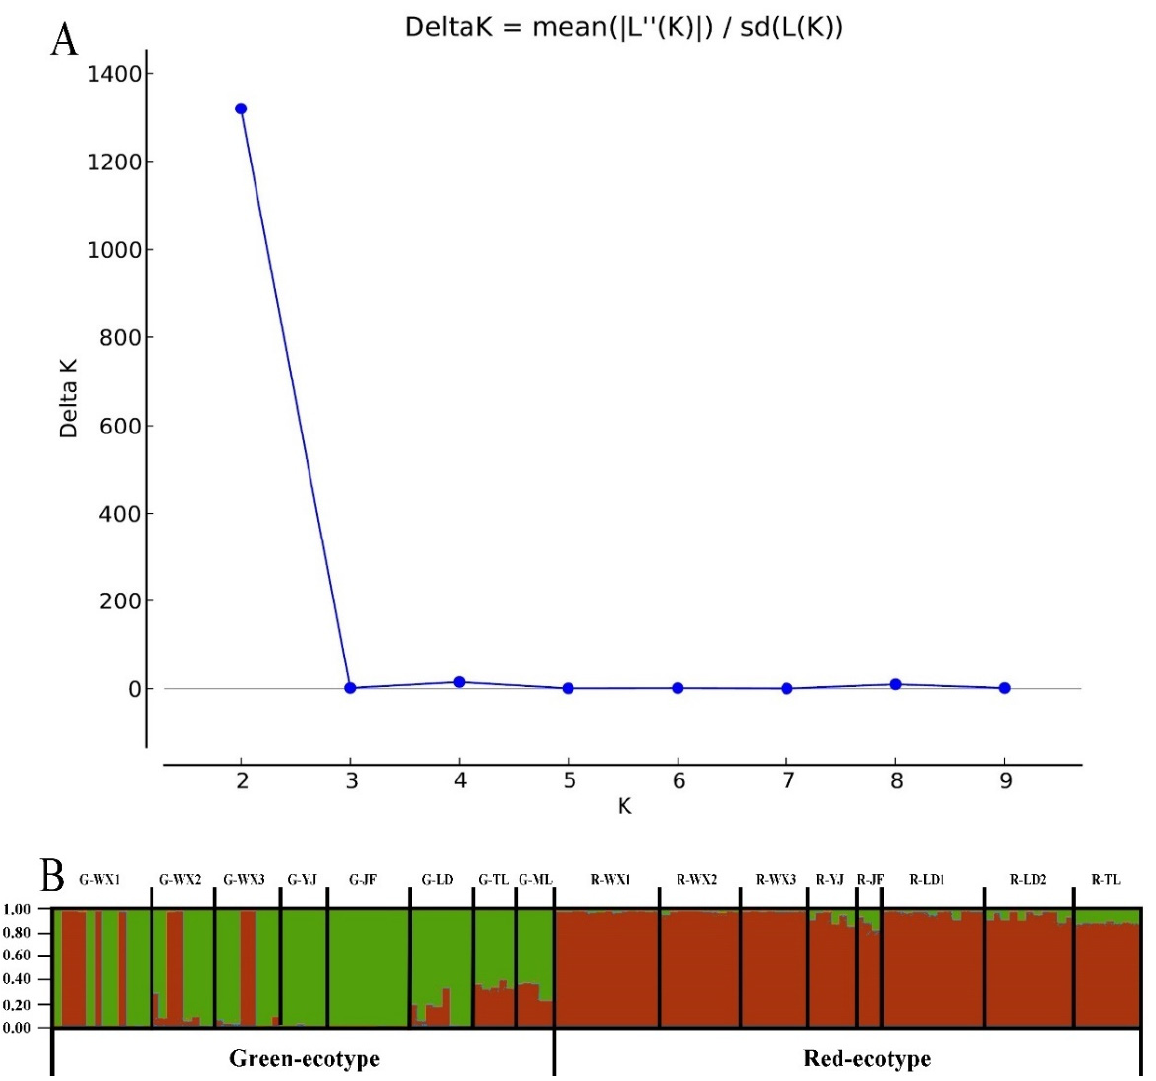
Figure 3. Delta K plot supporting and optimal value of K = 2 ( A ) and a corresponding STRUCTURE diagram ( K = 2) ( B ), where each vertical bar represents an individual and the height of the color of each bar represents the assignment probability to each cluster (red or green ecotype).